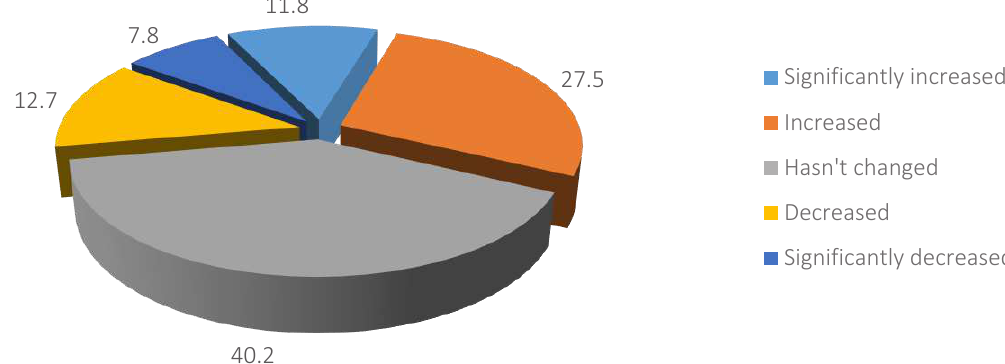
Figure 4. Has SMEs innovation increased during the COVID-19 pandemic